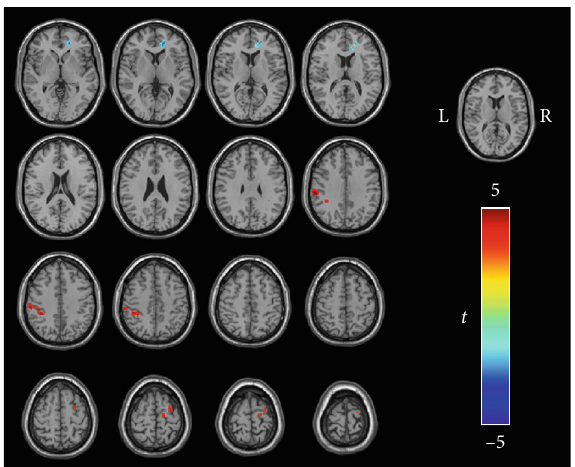
Figure 4: Regions showing di ff erent FC in the tinnitus patients compared with the healthy controls when the left superior parietal cortex was used as the seed (voxelwise P < 0 : 001 , FWE- corrected clusterwise P < 0 : 05 ). The tinnitus patients exhibited signi fi cantly increased FC from the left superior parietal gyrus to the left inferior parietal gyrus, the left superior marginal gyrus, and the right superior frontal gyrus but showed decreased FC to the right anterior cingulate cortex. The color bar indicates the t value of independent two-sample t -tests between the groups. Red represents regions with increased FC with seeds in the tinnitus patients compared with the healthy controls, while blue shows regions with decreased FC. Acronyms: DAN: dorsal attention network; FWE: familywise error; FC: functional connectivity; L: left; R: right.